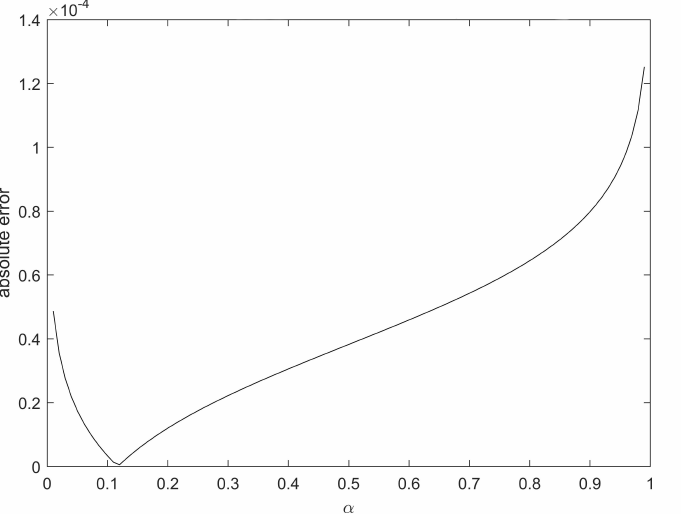
Figure 2. Absolute error of numerical solution and analytic solution.